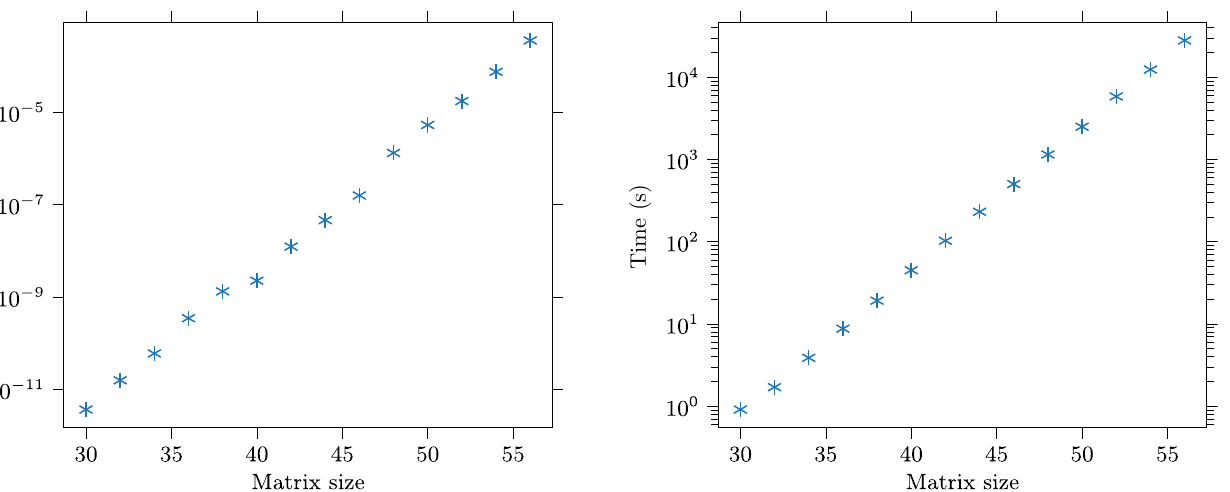
FIG. 4. The computation time of the loop hafnian of a random complex symmetric matrix in long double-complex precision using a Standard D96a v4 Microsoft Azure instance with 96 CPUs running at 2.345 GHz. For a matrix of dimension 56, the run time is approximately 7